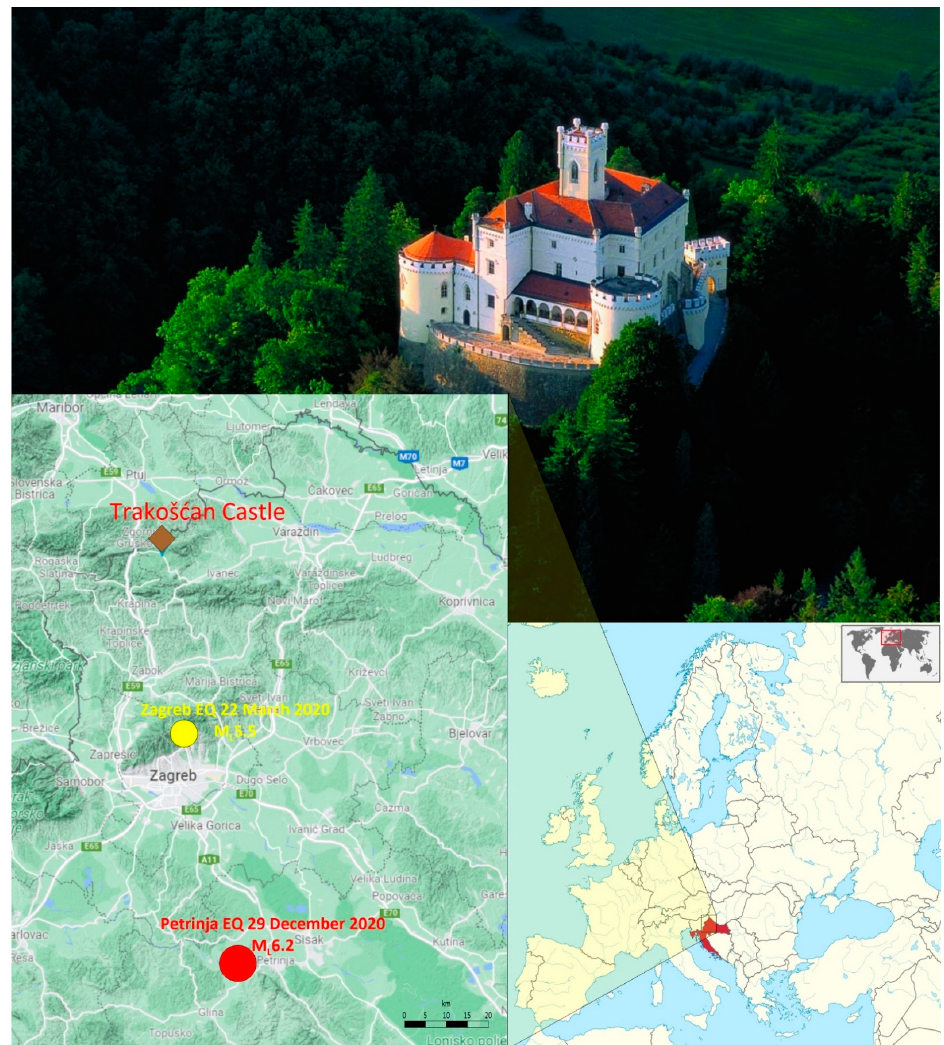
Figure 1. Photo and locations of Trakoš ć an Castle, and locations of the Zagreb March 2020 and the Petrinja December 2020 earthquakes.